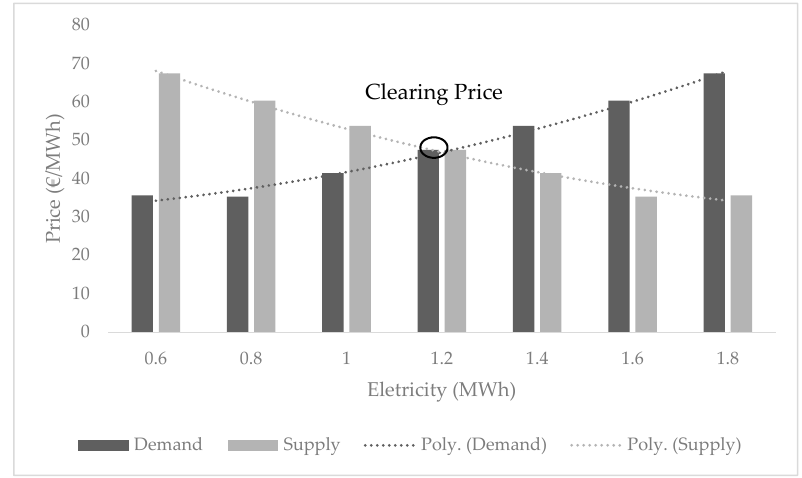
Figure 12. Clearing price of the market.